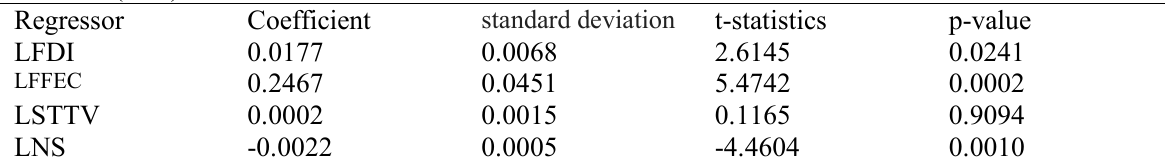
Table 6. Estimated long-run coefficients using the ARDL selected based on Akaike information criterion